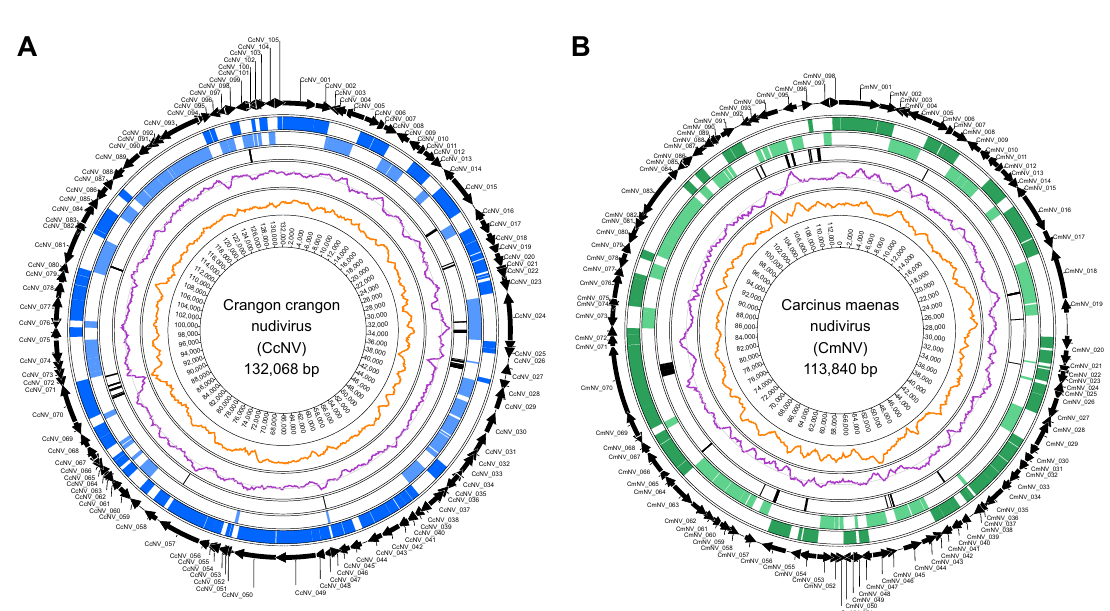
Figure 2. Circular genomic maps of ( A ) Crangon crangon nudivirus (CcNV) and ( B ) Carcinus maenas nudivirus (CmNV). The outermost to innermost tracks represent: (1) predicted protein-coding genes and their orientation, (2) predicted protein- coding genes on the forward strand, (3) protein-coding genes on the reverse strand, (4) tandem repeat regions, (5) GC content and (6) GC skew, (7) genome